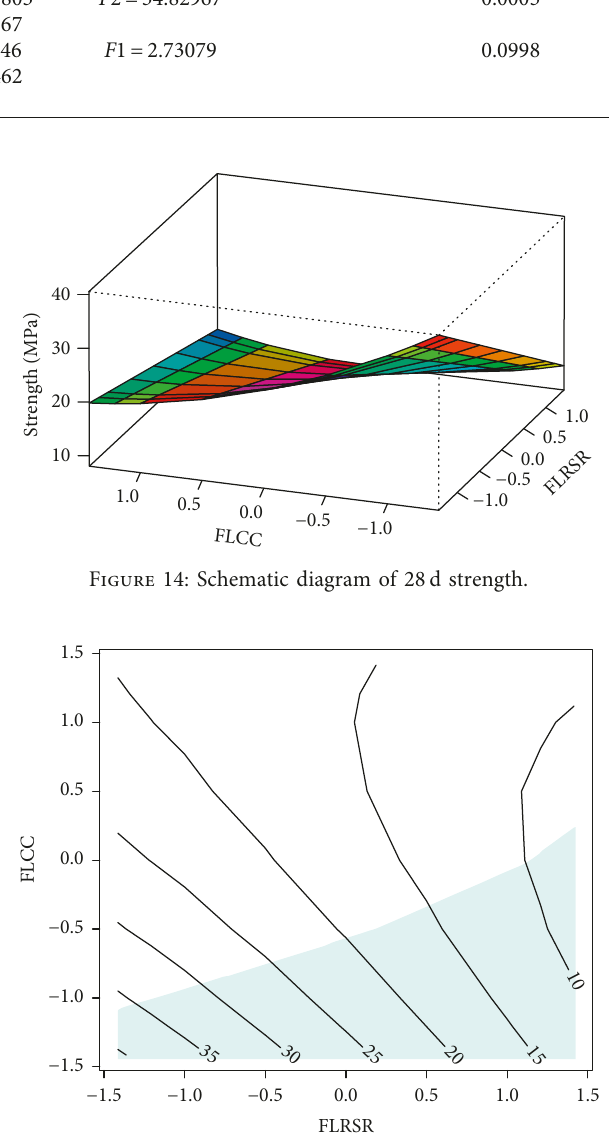
Figure 15: Contour map of 28d strength (for the contour map of uniformity 1 as the boundary, the line on blue background rep- resents the strength value when the uniformity of rubber distri- bution is less than 1, and the line on white background represents the strength value when the uniformity of rubber distribution is not less than